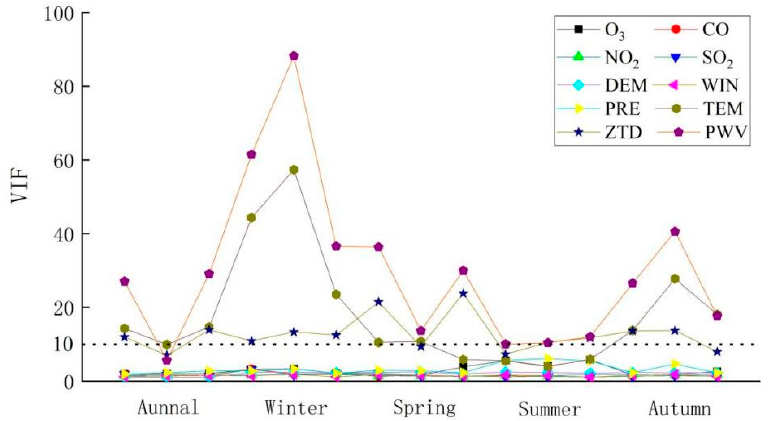
Figure 10. The results of the multicollinearity test. Magnitude of VIF (variance inflation factor) values for O 3 , CO, NO 2 , SO 2 , DEM, WIN, PRE, TEM, ZTD and PWV at different time stamps. Note: DEM means the elevation values obtained from the digital elevation model, WIN means wind, PRE means pressure, TEM means temperature, ZTD means zenith tropospheric delay, PWV means precipitable water vapor.